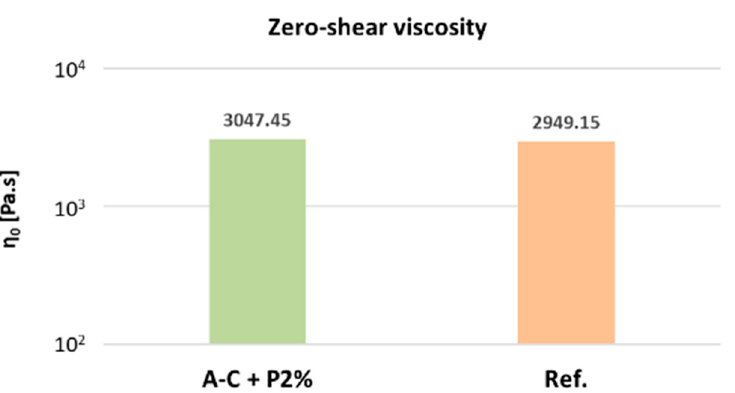
Figure 19. Comparison between the zero-shear viscosity ( η 0 ) values, calculated via the Carreau– Yasuda model, for the sample prepared with ternary associations of A (1.25% w/w), C (1% w/w), and P (2% w/w), and for the reference product (Ref.).